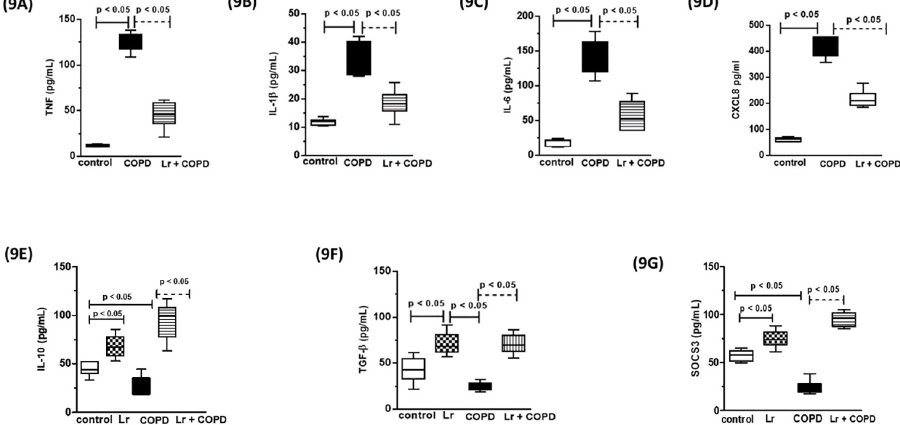
The in vivo findings indicated that the anti-inflammatory effects of Lr treatment was associated with the modulation of the genes associated with NF κ B and STAT3 pathways (Fig 10). In con- cordance, both the murine bronchial epithelial cells (10A and 10B) and human bronchial epi- thelial cells (10C and 10D) cells presented with increased expression of mRNA to NF- κ B and STAT3 genes upon exposure to CSE, in comparison to control cells. The Lr treatment main- tained the expression of these genes at levels similar to those observed in the control cells,